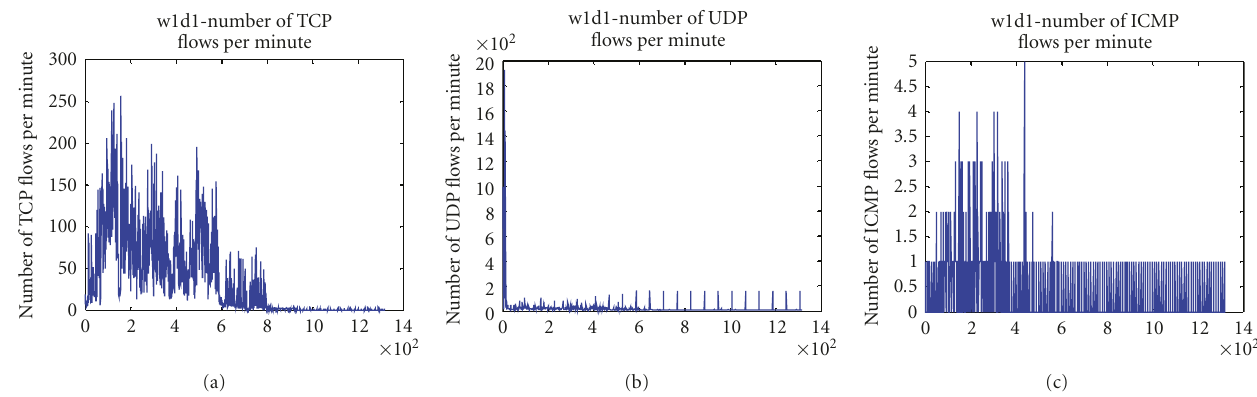
Figure 2: Number of flows per minute over one day with normal tra ffi c only.